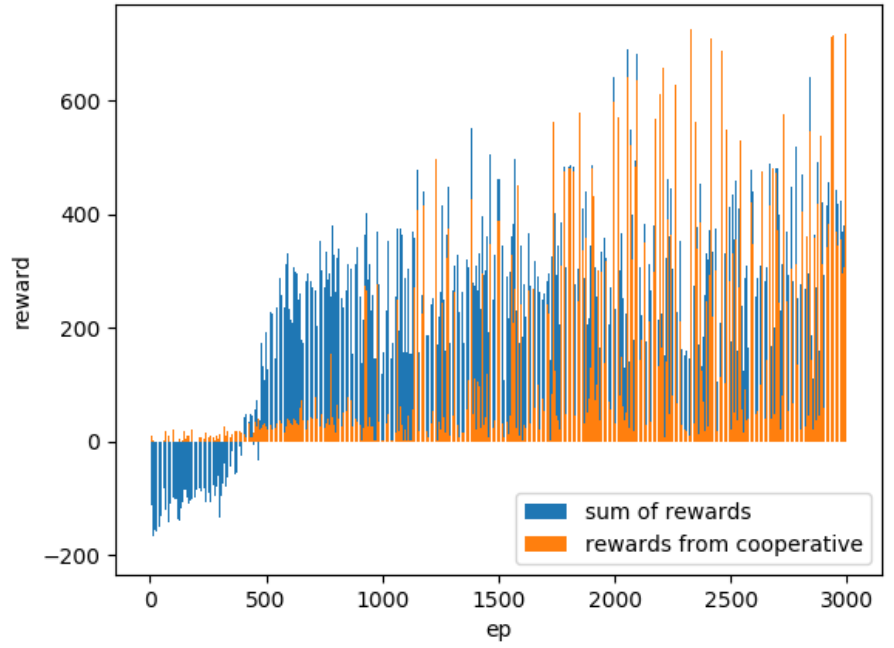
Figure 6. Average number of times collaborative rewards are earned for each method (no cooperative rewards, with cooperative rewards, and meta-strategy).